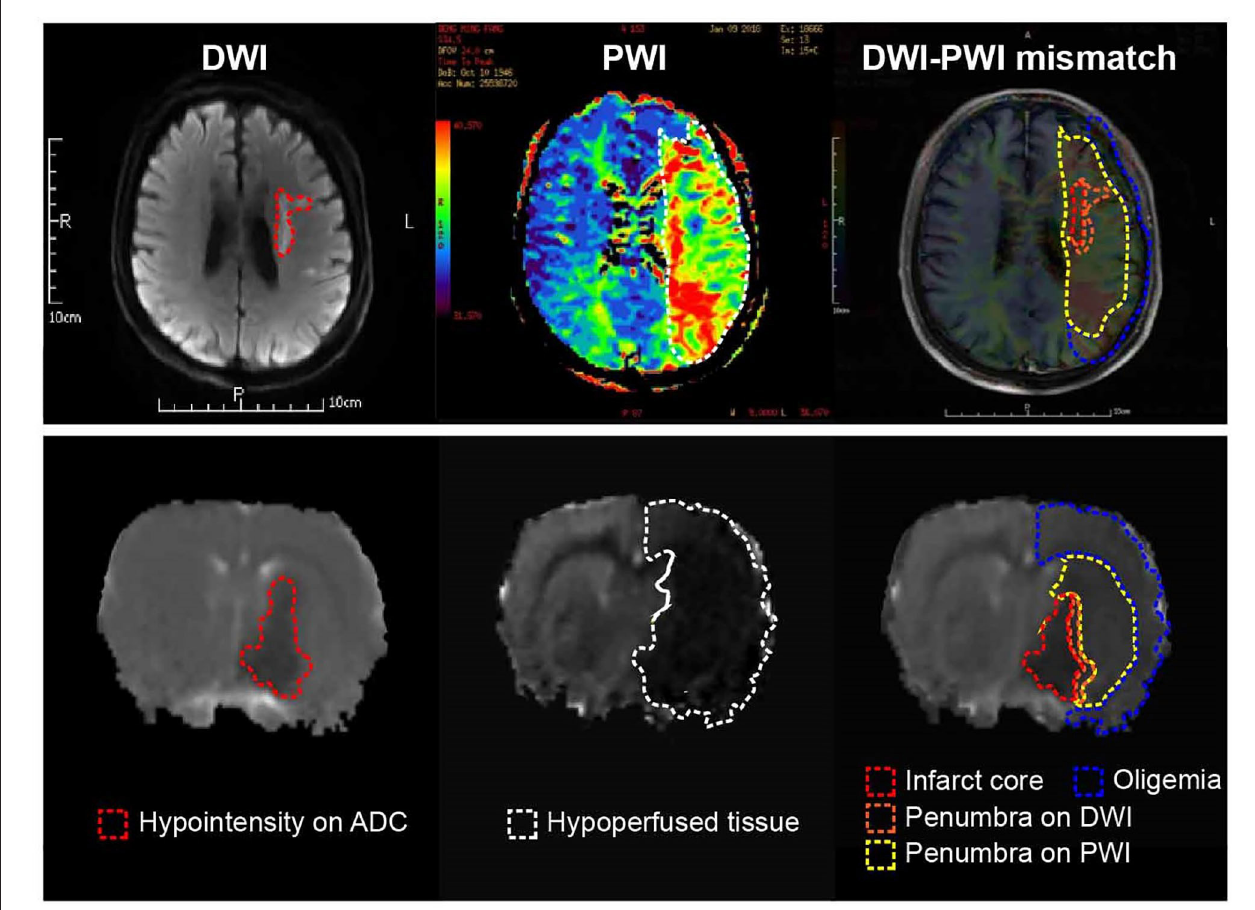
FIGURE 2 | Current concept of the ischemic penumbra. Both clinical (Upper) and experimental (Below) MRI data showed early abnormality on DWI equals the infarct core plus a part of tissue at risk (penumbra), and the perfusion deficiency on PWI includes part of the region of benign oligemia. MRI, magnetic resonance imaging; PWI, perfusion-weighted